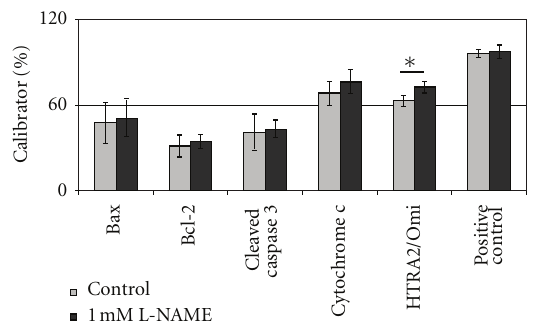
Figure 2: Change in concentration of apoptosis-related proteins after treatment with L-NAME. Bars display the change in concen- tration of Bax, Bcl-2, cleaved caspase 3, cytochrome c, HTRA2/Omi, and the positive control after treatment of VSMCs with 1 mM L- NAME for 1h. ∗ : P = 0 . 04. (68 . 46 ± 8 . 61 versus 76 . 39 ± 8 . 48% of calibrator) although